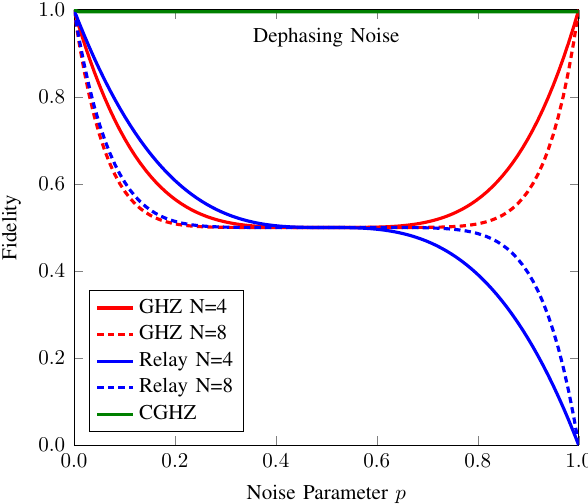
Figure 5. Fidelity of the anonymous entanglement of CAQT compared to those of conventional GHZ- state-based AQT and relay-based AQT under dephasing noise. Here, the dotted (solid) line denotes the fidelity of anonymous entanglement when the number of participants N is 4 (8). The fidelity values of the anonymous entanglement of conventional GHZ-state-based AQT (GHZ), relay-based AQT (Relay), and our counterfactual GHZ-state-based AQT (CGHZ) are represented by the red, blue, and green lines, respectively. The fidelity of our proposed protocol is the same for both N = 4 and N =